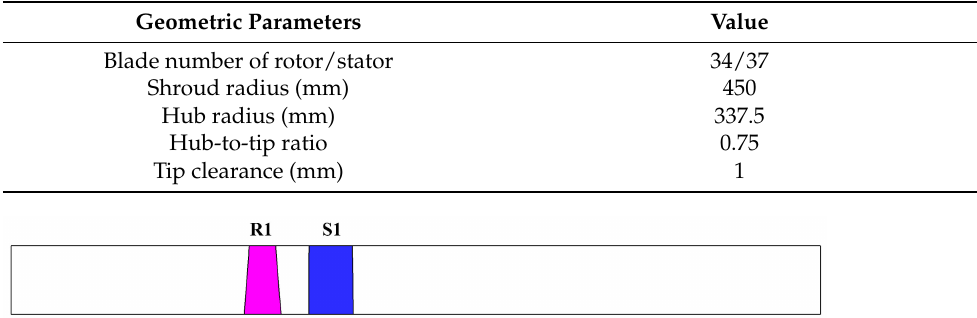
Table 1. Geometric parameters of the single-stage compressor.